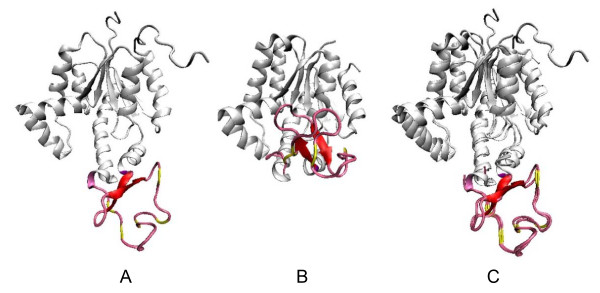
Flexible structural comparison of protein 2ak3 and 1aky. A. Protein 2ak3. B. Protein 1aky. C. Flexible structural alignment of 2ak3 and 1aky created by FATCAT. The flexible regions are aligned together.